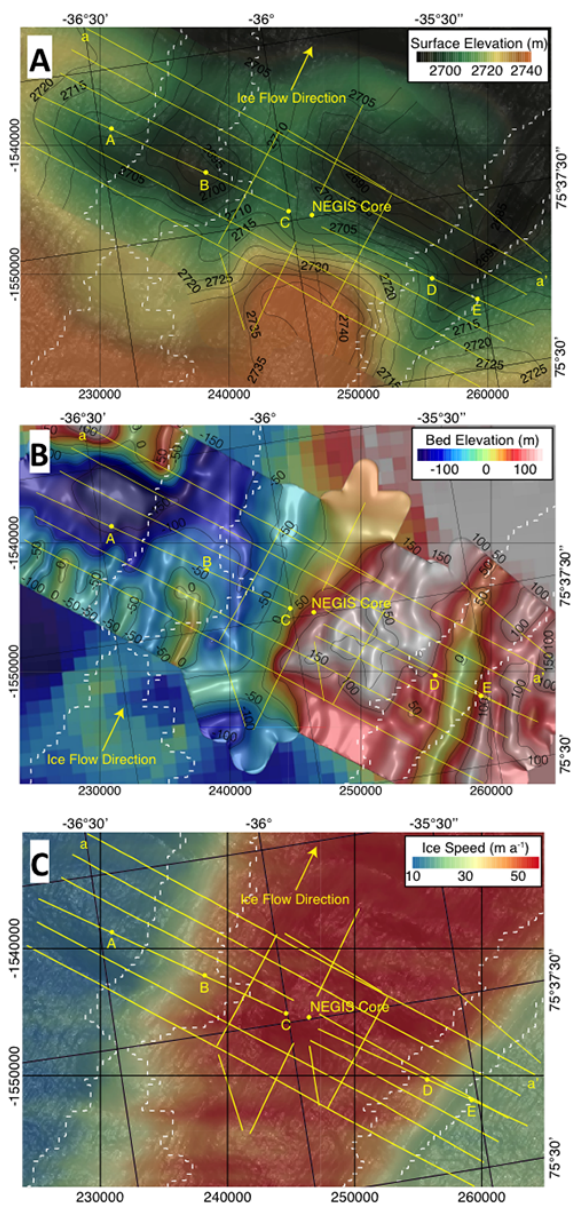
Figure 4. (a) Surface and (b) bedrock elevation of NEGIS interpo- lated from kinematic GPS profiles and RES profiles (yellow lines), respectively, and (c) ice speed in the vicinity of NEGIS (Joughin et al., 2010). Seismic sites are labelled A–E. Radar profile a–a’ is shown in Fig. 6. The shallow core site (NEGIS core) is in the centre of the geophysical survey grid (yellow lines). In (a) black contours (1m interval) show surface elevation (relative to WGS84 ellipsoid) and in (b) they show bed elevation (25m interval). Background bed topography is from Bamber et al. (2013). In all figures, white dashed lines mark shear margins (areas with longitudinal strain rates greater than 2 × 10 − 3 yr − 1 ). Background is MODIS imagery with Lamber- tian radiance applied (T. Haran, personal communication, 2012) in (a) and (c)